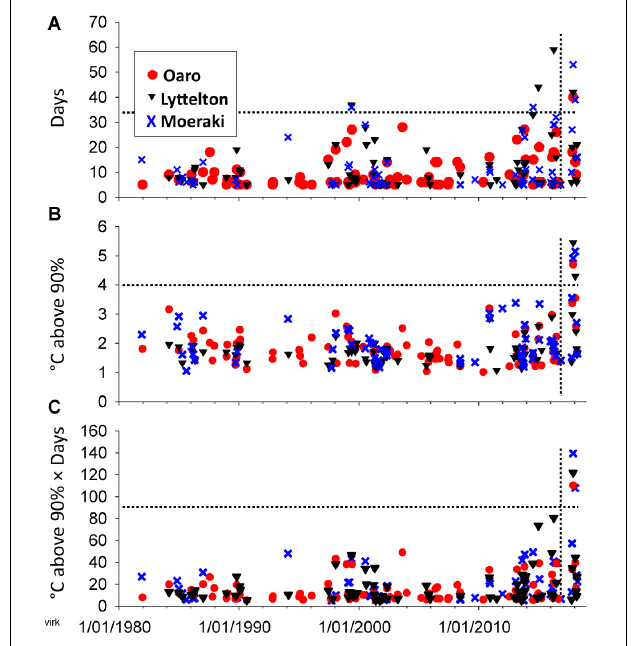
FIGURE 2 | Duration (A) , maximum intensity (B) , and cumulative intensities (C) of marine heatwaves recorded from Oaro, Lyttelton and Moeraki from 1/1-1980 to 20/4-2018 Heatwaves were calculated from satellite derived daily sea surface temperatures in the r package Marine Heatwaves; 90% = the 90% climatic quantile calculated from 38 years of data. Dotted lines were inserted to highlight the long durations and extreme maximum and cumulative intensities of the 2017/18 summer